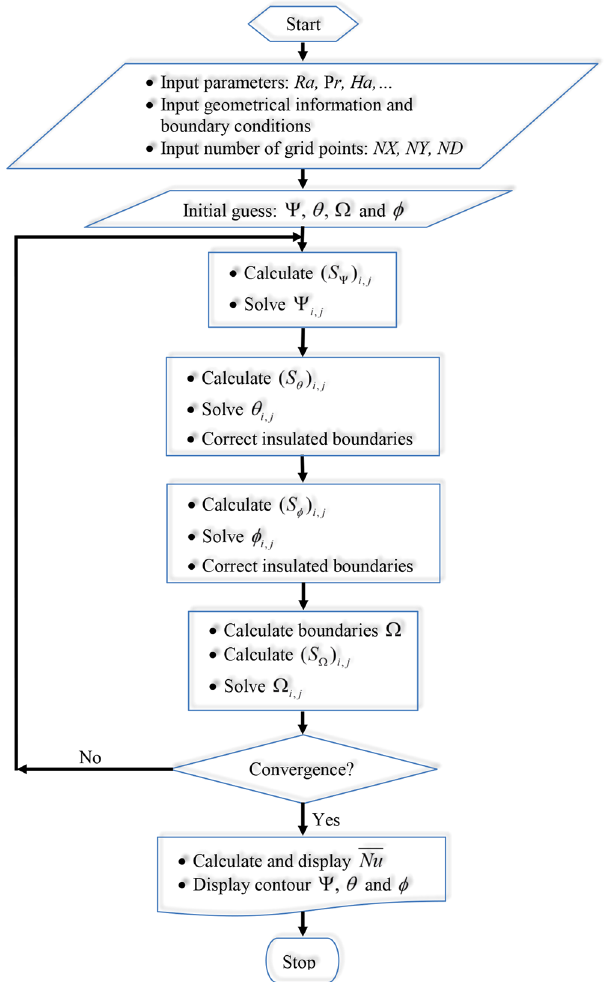
Figure 2. Flowchart for the solution procedure of MHD convective heat transfer in a square cavity with conductive inner